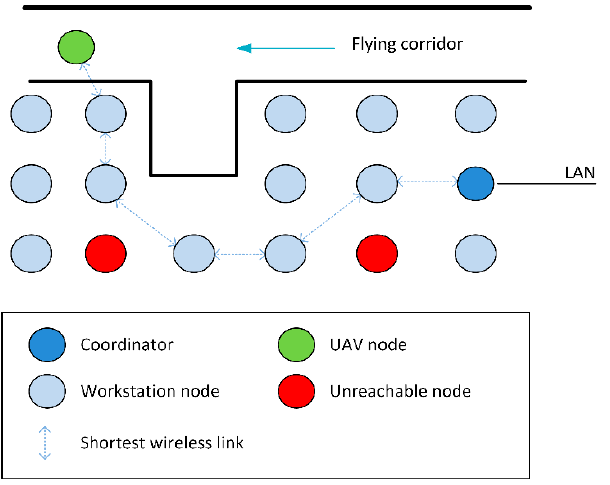
Figure 13. Zigbee mesh topology.